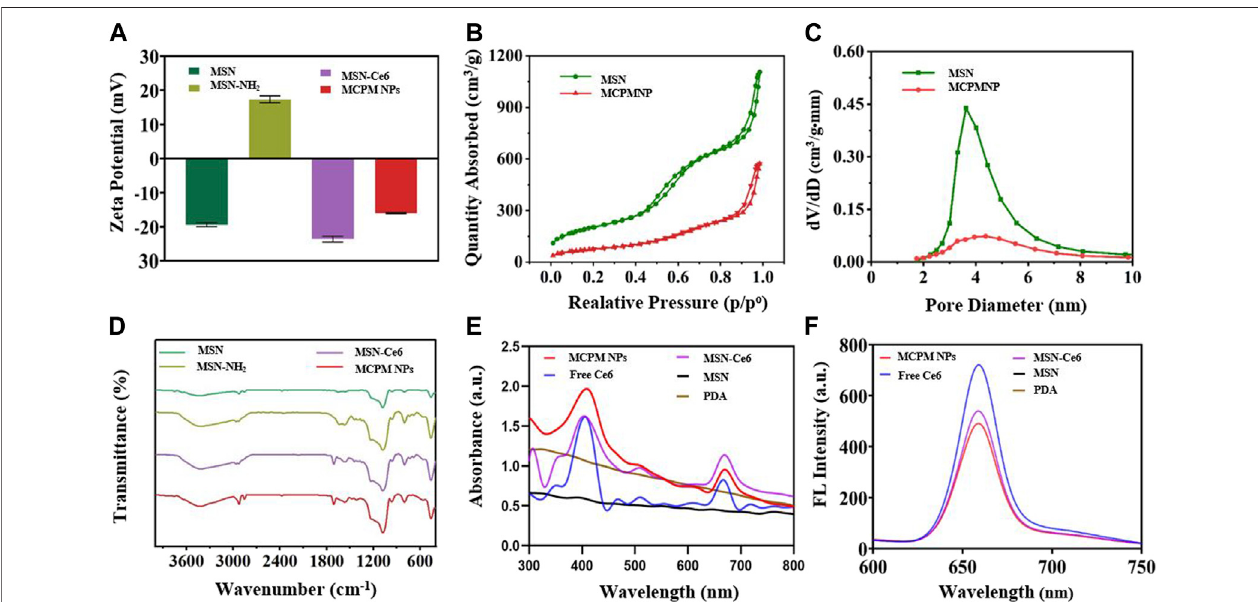
FIGURE 2 | Zeta potentials and spectra of different nanoparticles. (A) Zeta potentials. (B) Nitrogen adsorption – desorption isotherms of MSN and MCPM NPs. (C) Pore sizedistributionofMSN and MCPM NPs.(The green linerepresentstheMSN,and the red linerepresents theMCPM NP). (D) FT-IR spectra. (E) UV-Vis absorption spectra. (F) Fluorescence spectra.